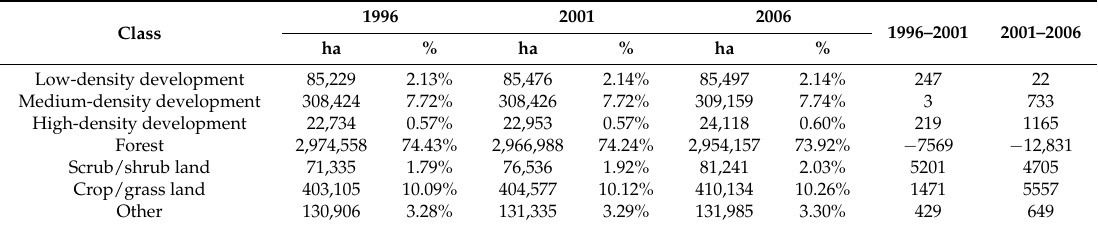
Table 3. Quantities of land cover/use changes over time in terms of hectare and percentage of each class.